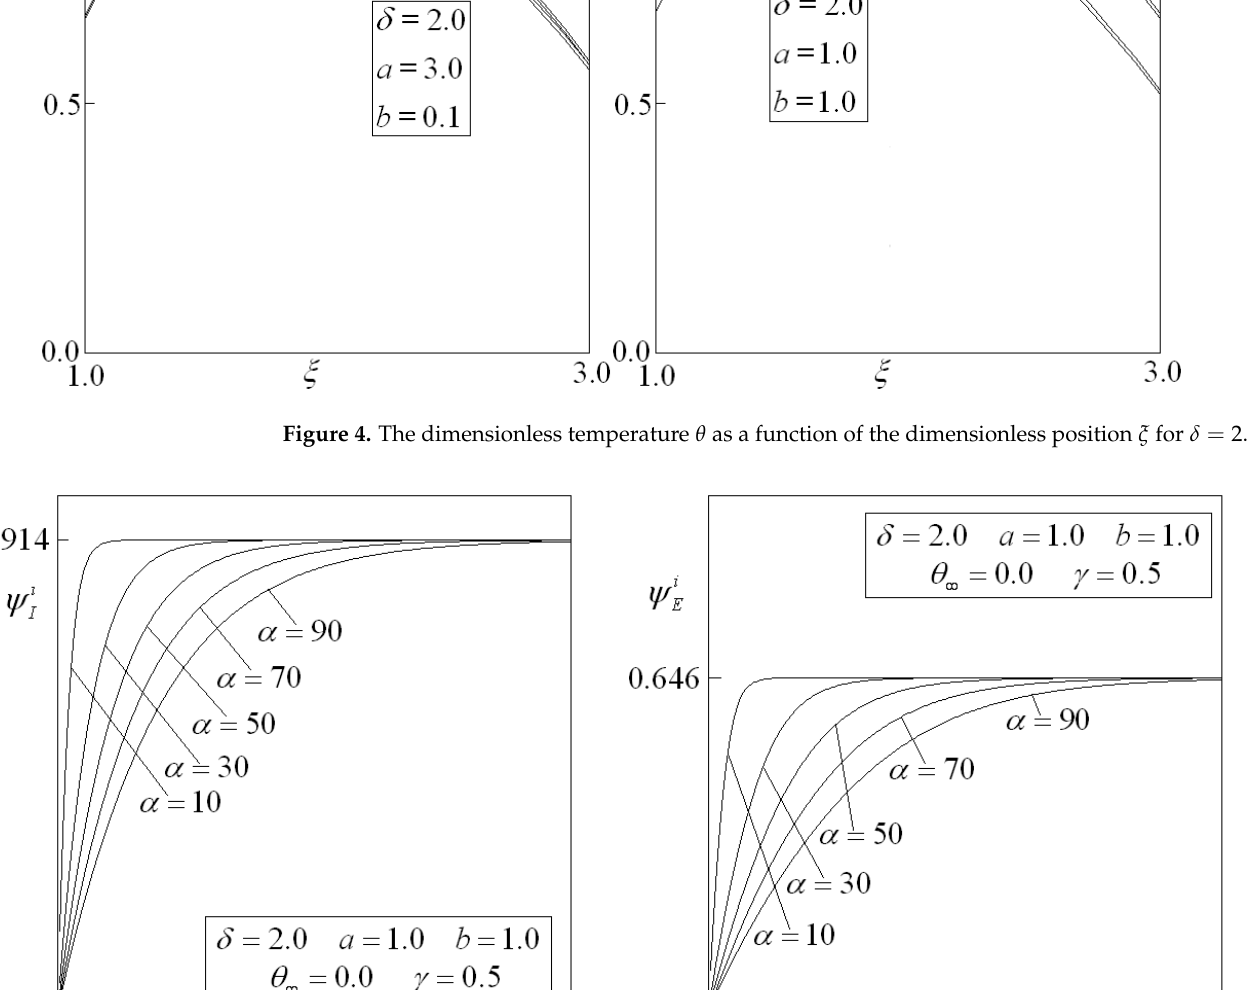
Figure 5. The constants constant α for the particular case in which δ = 2.0, a = b = 1.0, θ ∞ = 0.0, and γ = 0.5. In this case, θ I = 0.914 and θ E =